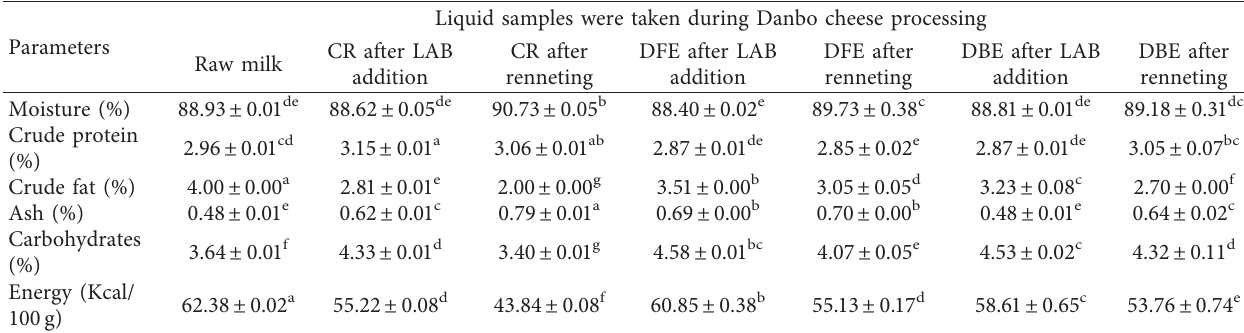
Table 7: Proximate composition of raw milk and liquid samples during Danbo cheese processing.